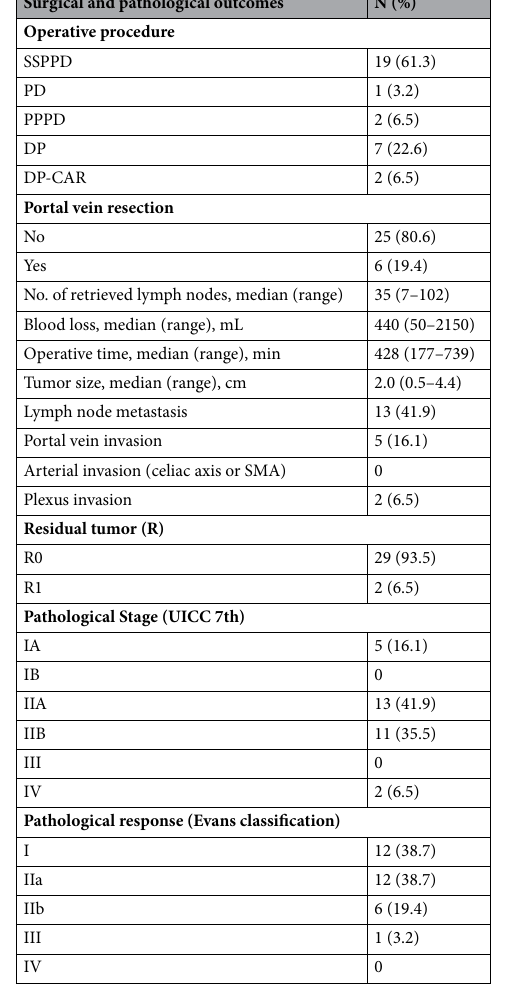
Table 3. Surgical and pathological outcomes in neoadjuvant complete patients (n = 31). SSPPD, subtotal stomach-preserving pancreaticoduodenectomy; PD, pancreaticoduodenectomy; PPPD, pylorus-preserving pancreaticoduodenectomy; DP, distal pancreatectomy; DP-CAR, distal pancreatectomy with en-bloc celiac axis resection; SMA, superior mesenteric artery; UICC, Union for International Cancer